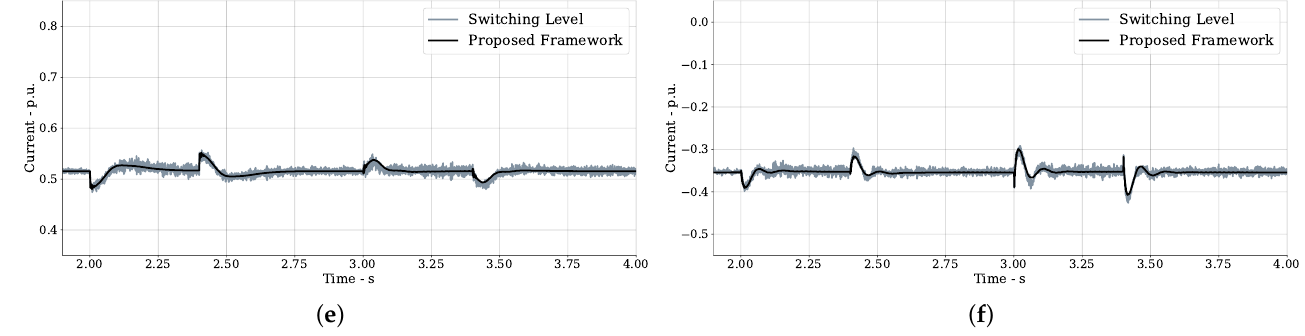
Figure 10. Injected currents in the buses. ( a ) Bus 1 (VC-VSC/MMC net current)— d axis; ( b ) Bus 1 (VC-VSC/MMC net current)— q axis; ( c ) Bus 2 (CC-VSC net current)— d axis; ( d ) Bus 2 (CC-VSC net current)— q axis; ( e ) Bus 3 (CC-VSC net current)— d axis; ( f ) Bus 3 (CC-VSC net current)— q axis.